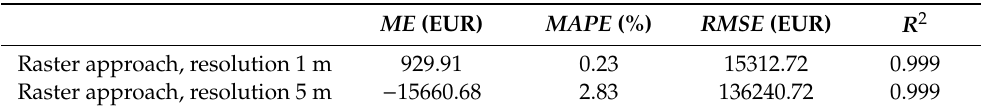
Table 5. Statistical analysis of LATIS tool with respect to FLIAT tool for statistical sectors of the Belgian coast.